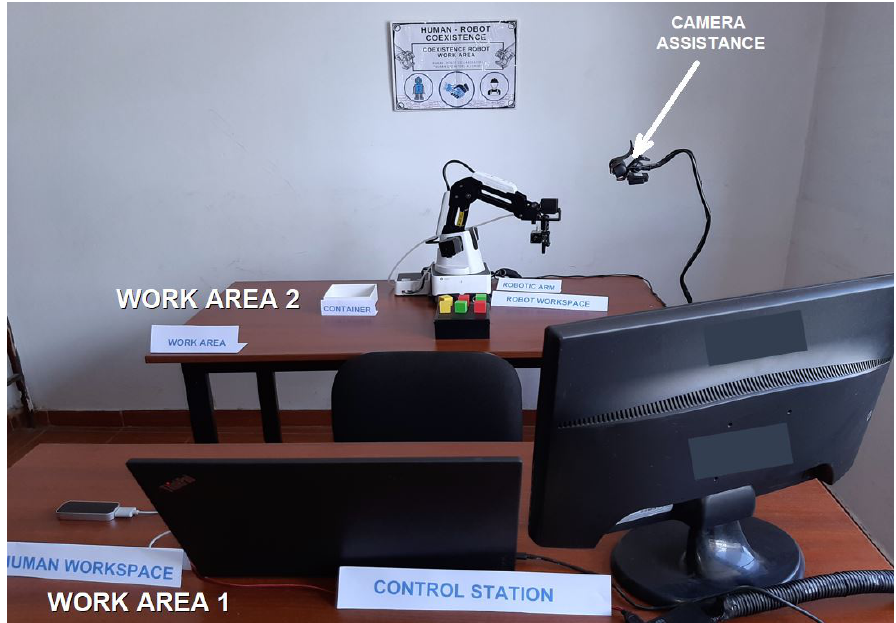
Figure 9. Human–robot workspace. Workspace 1 is the area where the user operates the robotic arm without line of sight to the robot. Workspace 2 is the area where object manipulation tasks are